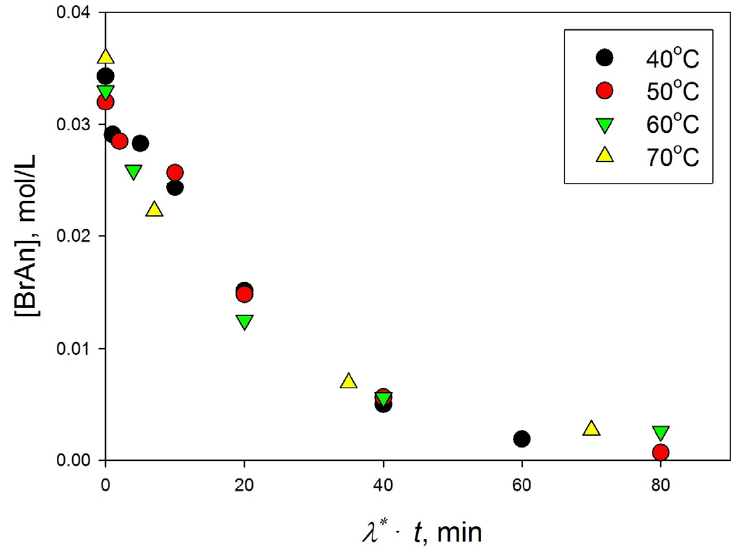
Figure 8. Consumption of BrAn at various temperatures depending on the “conditional” time ( λ *·t), λ * = 1.0, 2.0, 4.0 and 7.0 for 40, 50, 60 and 70 °C, respectively.